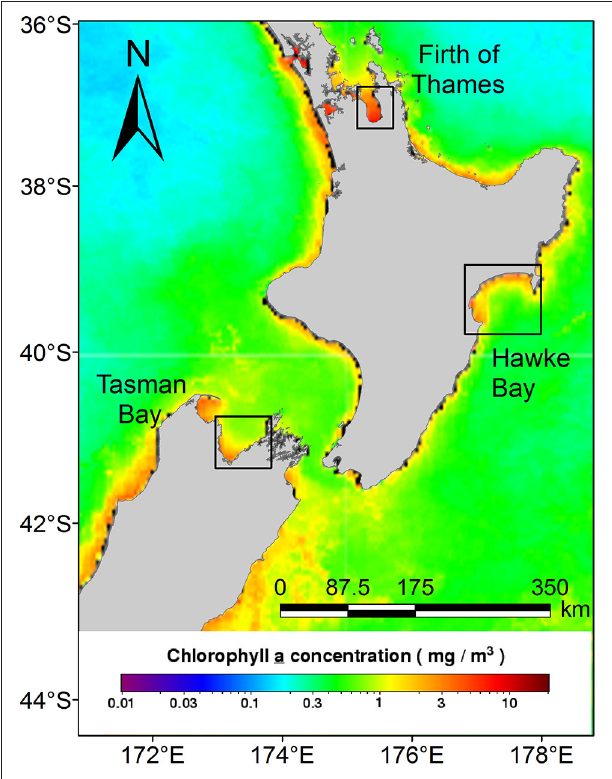
FIGURE 1 | The two New Zealand coastal regions (Tasman and Hawke bays) that are the focus of the study are shown in the two southern boxes with an additional Firth of Thames region (northern-most box) which is discussed, but which is not analyzed in detail here. Mean annual global chlorophyll- a concentrations from the Case 1 OC3M algorithm are shown for 2012. Chlorophyll- a data were sourced at a spatial resolution of 4 km (level 3 data) from the Ocean Color website (https://oceancolor.gsfc.